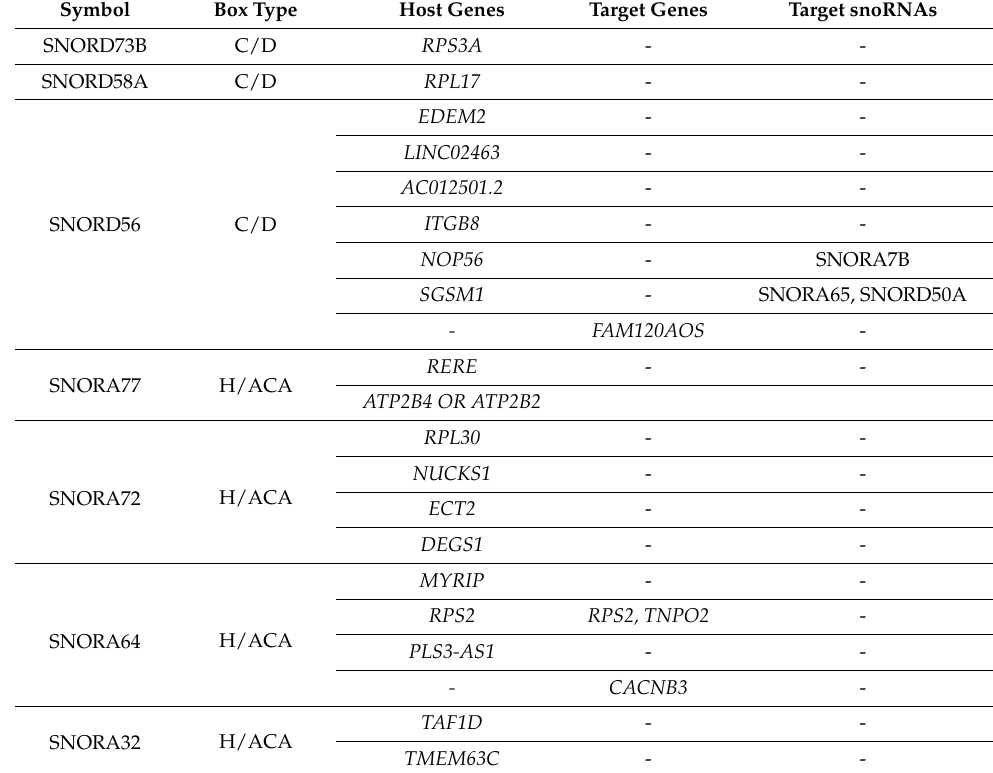
Table 2. List of the snoRNAs examined in the study and interactions with genes and